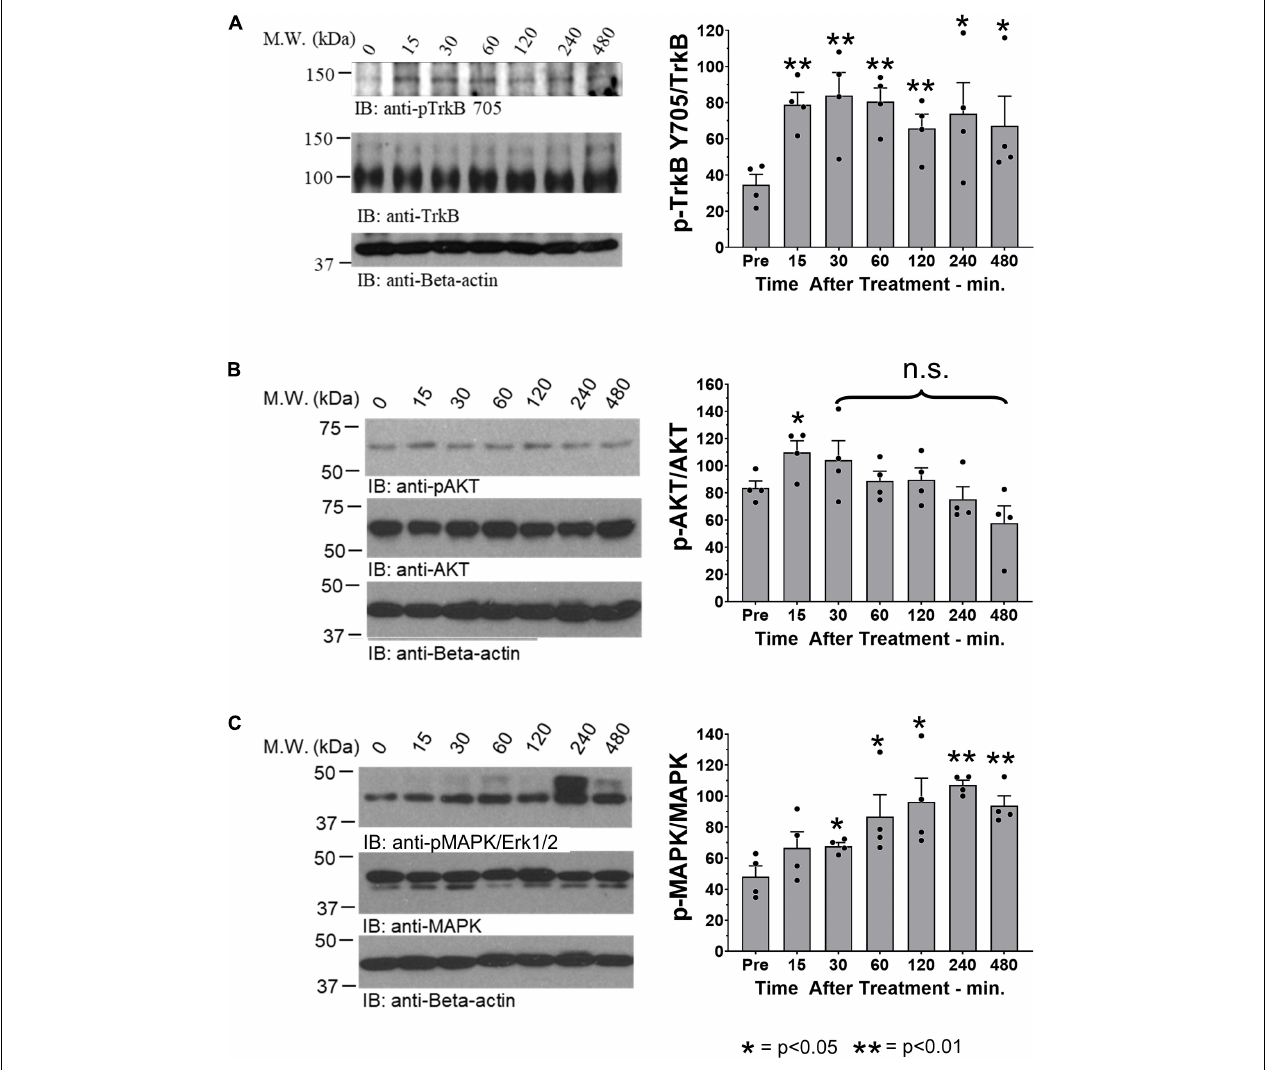
FIGURE 1 | Oral R13 treatment stimulates TrkB phosphorylation and a downstream effector at the site of nerve injury. On the left side of each panel, examples of blots of sciatic nerves at the site of injury prior to (0 min) and at 15, 30, 60, 120, 240, and 480 min after oral administration of R13 are shown. On the right are quantitative results from blots from four nerves ( n = 4). Bands of specific protein were densitometrically analyzed and normalized to the signal intensity of beta-actin. For each of the three proteins studied, the ratio of the expression of their activated (phosphorylated) form relative to total protein expression was calculated. Significance of differences at different times after administration from that prior to R13 administration was evaluated using an unpaired t -test: * p < 0.05 ** p < 0.01, n = 4. (A) Immunoblots for anti- phosphorylated TrkB (pTrkB Y705), TrkB, and beta-actin. (B) Immunoblots for anti- phosphorylated AKT (pAKT), AKT, and beta-actin. (C) Immunoblots for anti- phosphorylated MAP kinase (pMAPK/Erk1/2), MAPK/Erk1/2, and